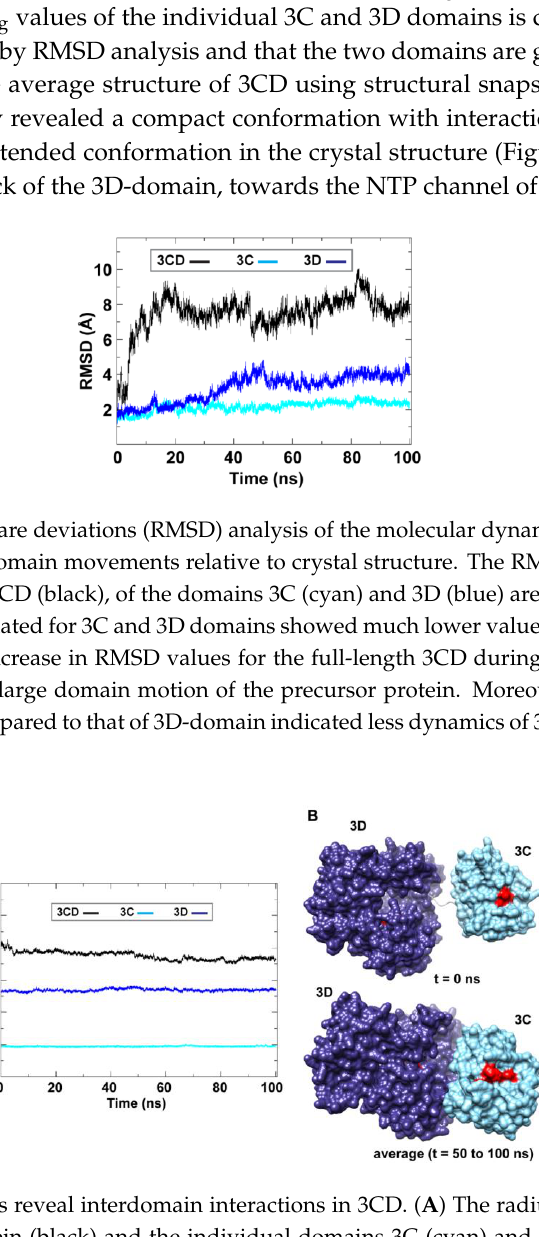
the full-length 3CD protein (black) and the individual domains 3C (cyan) and 3D (blue) are plotted as a function of time. The R g of 3CD substantially decreased during the simulation, whereas the R g of 3C-domain remained almost constant and the R g of 3D-domain showed very small variation. The decrease in R g values of 3CD reflects the development of the interactions between 3C and 3D domains during simulations. ( B ) Shown are the 3CD structure at the starting time of the simulation ( t = 0) and the average structure calculated over the last 50 ns of the trajectory of monomer 1. The structures are rendered as surface, the 3C and 3D domains are colored cyan and blue, respectively. The active-site residues of the protease (His-40, Glu-71, Cys-147) and polymerase (Asp-416, Asp-511, Asp-512) are indicated by red color to show the relative orientation of the two domains. The starting 3CD structure adopts an extended conformation with no interdomain interactions in contrast to that observed in the simulated average